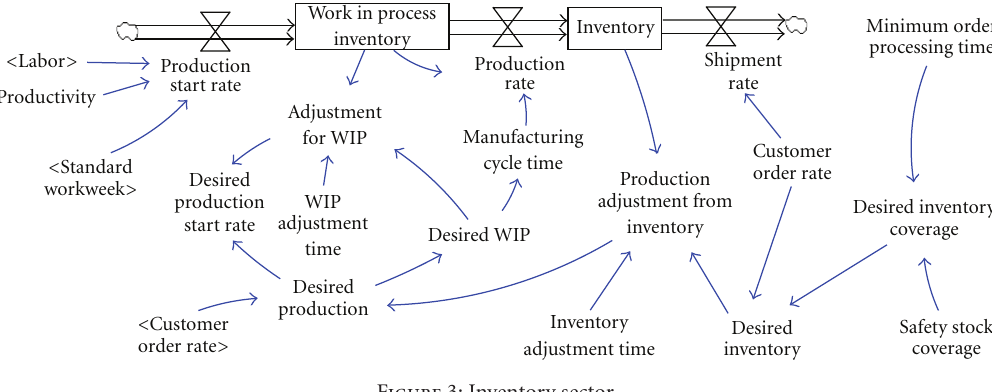
Figure 3: Inventory sector.